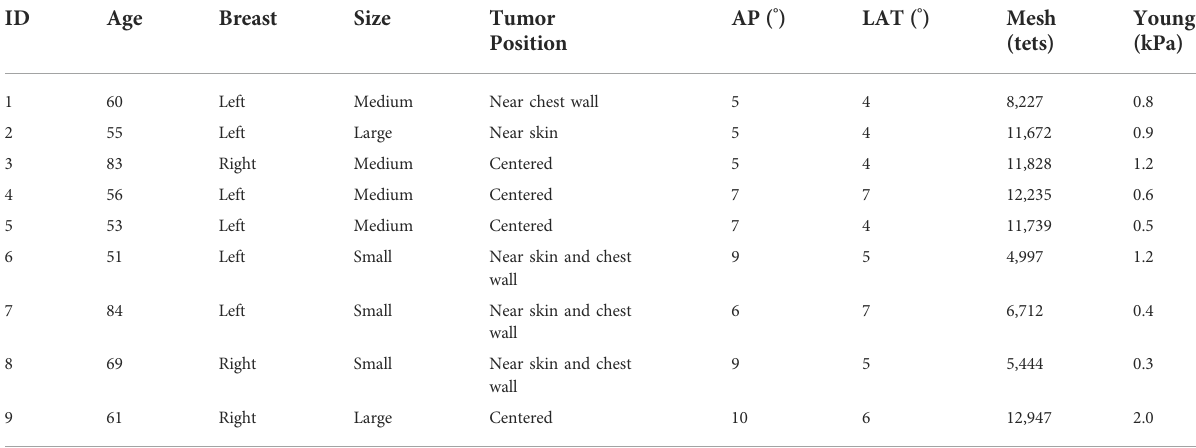
TABLE 1 Characteristics of the nine patients analyzed in the study, including age, breast characteristics, tumor position, anteroposterior (AP) and lateral (LAT) inclination of the surgical bed, mesh size (in tetrahedra) of the simulated volume, and estimated Young modulus.